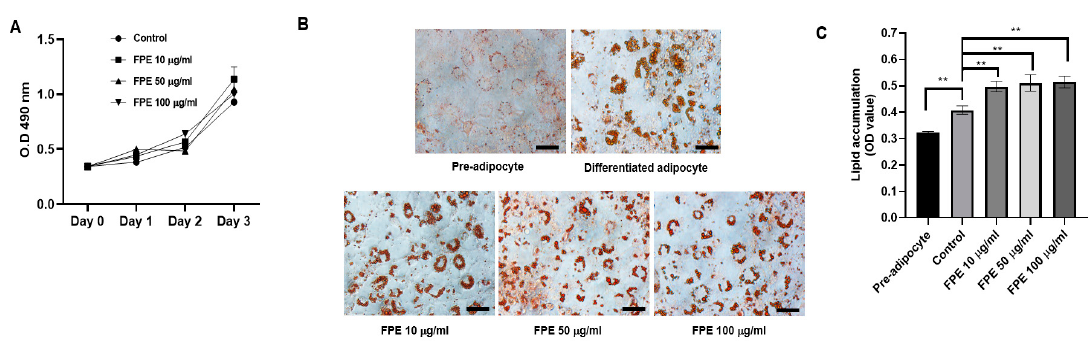
Figure 2. Effect of FPE on 3T3L1 pre-adipocytes . ( A ) Cytotoxicity assay of 3T3L1 cell lines treated with various concentrations (10, 50, and 100 μ g/mL) of FPE displayed no significant toxicity effect on 3T3L1 pre-adipocytes at 0, 24, 48, and 72 h post-treatment with FPE. ( B ) Effect of FPE in enhancing adipogenesis in pre-adipocyte cell lines. 3T3-L1 preadipocytes were differentiated to adipocytes; the cells were treated with 10, 50, and 100 μ g/mL FPE throughout the period of differentiation. At day 10 after initiation of differentiation, cells were stained with Oil Red O and visualized using a light microscope. Each figure shows the amount and size of droplets of adipocyte cells upon Oil Red O staining. Scale bar = 50 μ m. ( C ) Adjacent panel graphically shows the absorbance of the lipid droplets after staining cells with Oil Red O for 30 min. Results are given as mean ± SEM; n = 3, ** p < 0.01.